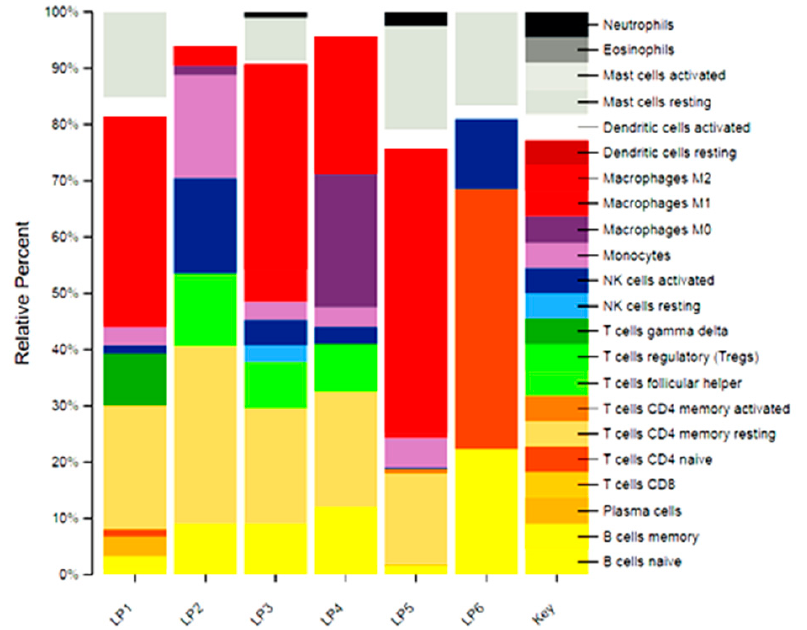
Figure 5. CIBESORT analysis of immune intratumoral populations and relative specific percentage. Table 3. CIBESORT analysis of immune intratumoral populations and related LMR before surgery.